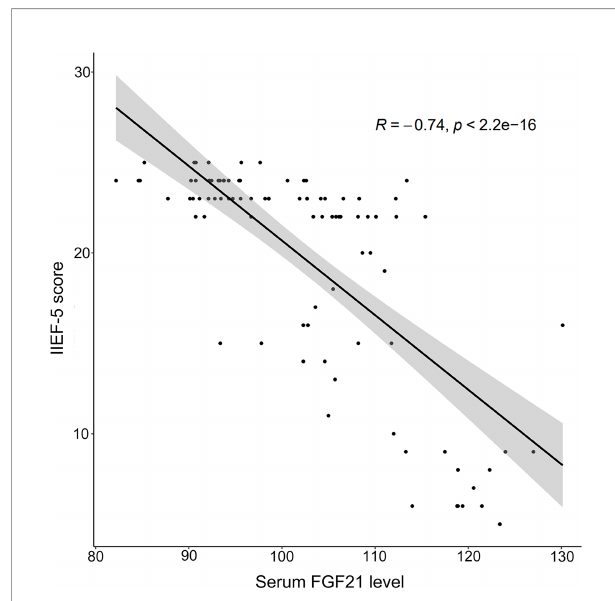
FIGURE 1 | The Spearman correlation between serum FGF21 and IIEF-5 score in human study.